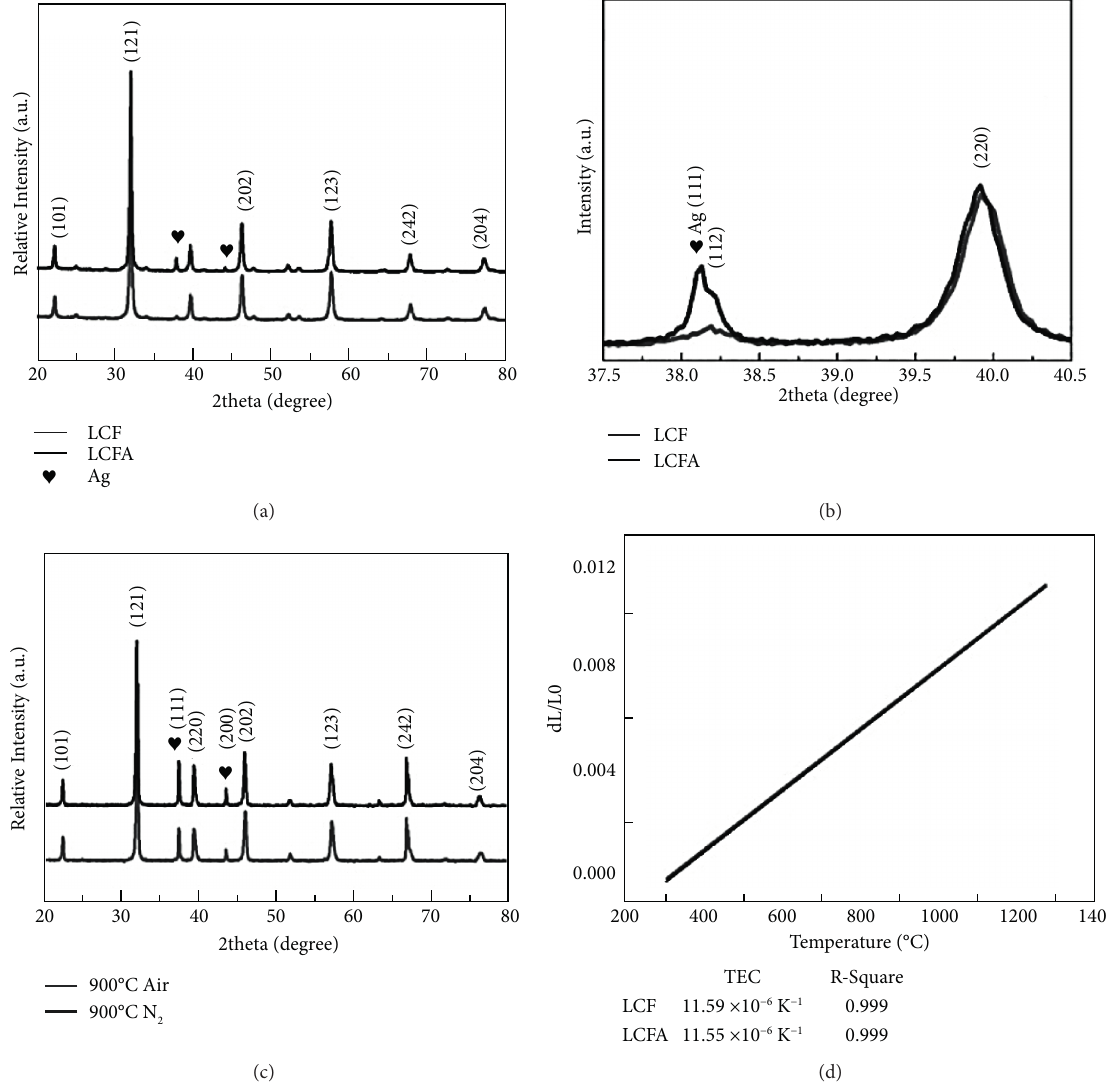
Figure 5: The operator approximates the amplitude of the continuous gradient of the edge